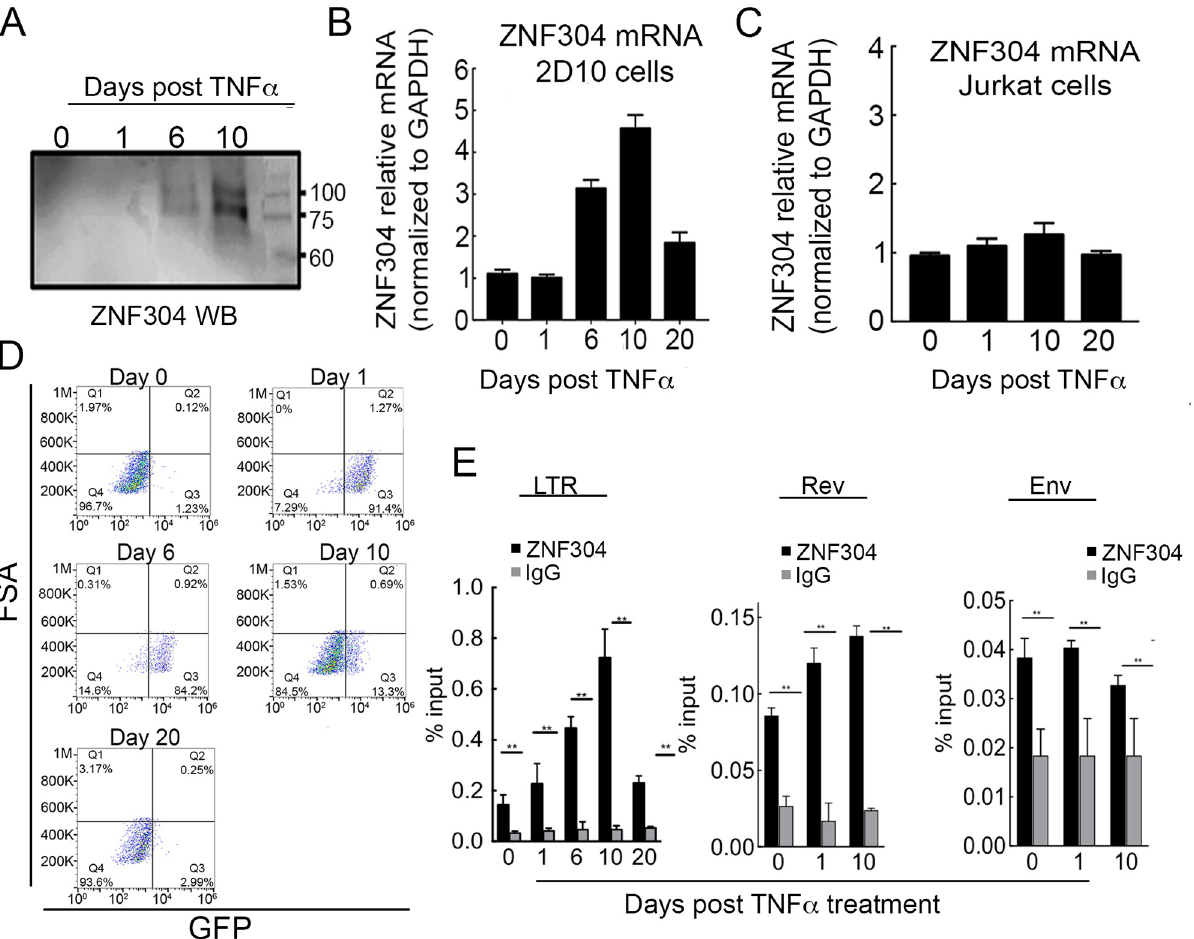
Fig 3. ZNF304 expression levels and promoter occupancy are elevated upon cell activation. A. ZNF304 protein expression levels following TNF α treatment – 2D10 cells were treated with TNF α to activate proviral HIV-GFP expression and then subjected to western blot at the indicated times post treatment to monitor ZNF304 expression using ZNF304 IgG. B. ZNF304 mRNA levels following TNF α treatment –RNA was extracted from 2D10 cells at the indicated time points post TNF α treatment and then subjected to RT-qPCR to determine ZNF304 mRNA levels relative to GAPDH mRNA. Bar graphs show mean values ± SD of three independent experiments. Asterisks indicate different levels of statistical significance as calculated by a two- tailed Student’s t test ( �� p � 0.01). C. ZNF304 mRNA expression levels following cell activation in non-infected cells –Jurkat cells were treated with TNF α and mRNA levels of ZNF304 were determined at the indicated time points by RT-qPCR. Bar graphs show mean values ± SD of three independent experiments. D. HIV gene expression following TNF α activation –FACS dot blot of 2D10 cells showing HIV-GFP expression at the indicated time points following TNF α treatment. E. ZNF304 occupancy on the HIV genome –TNF α -treated 2D10 cells were subjected to ChIP-qPCR at the indicated time points post cell activation using ZNF304 IgG. qPCR was performed using primers located on the HIV genome (primer positions are shown in S1 Fig). Bar graphs show mean values ± SD of three independent experiments. Asterisks indicate different levels of statistical significance as calculated by a two-tailed Student’s t test ( �� p � 0.01).